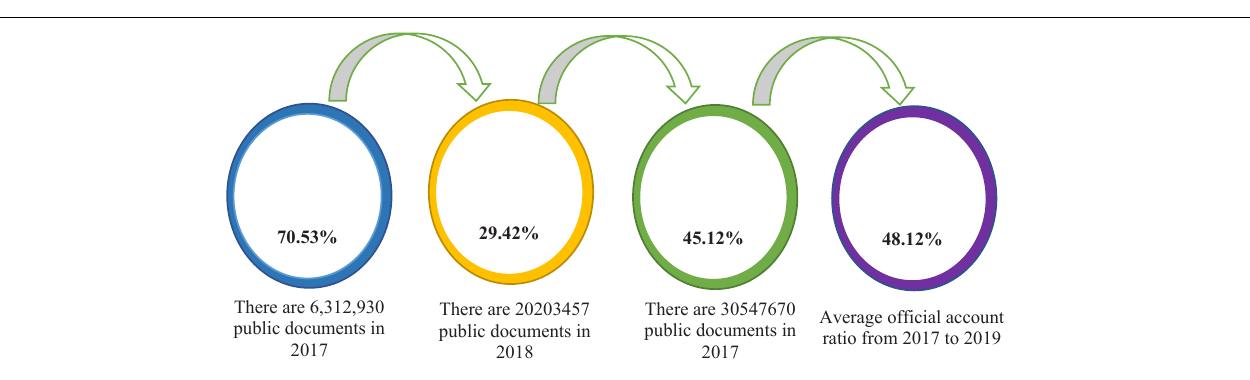
FIGURE 9 | Proportion of the number of open cases on China Judgment Document Network from 2017 to 2019.